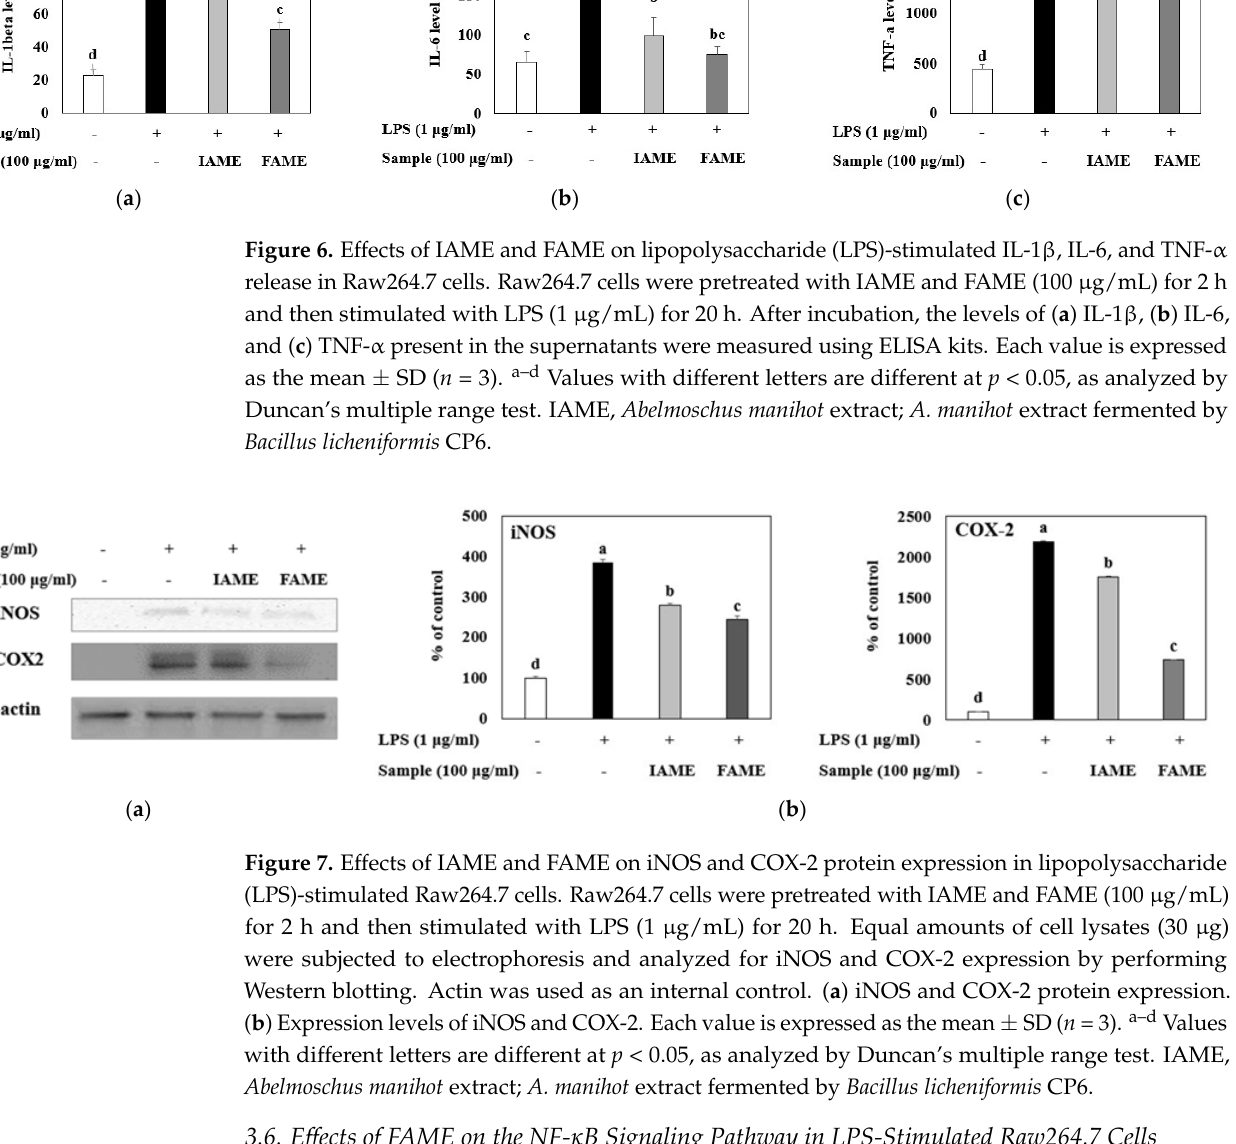
Figure 6. Effects of IAME and FAME on lipopolysaccharide (LPS) ‐ stimulated IL ‐ 1 β , IL ‐ 6, and TNF ‐ α release in Raw264.7 cells. Raw264.7 cells were pretreated with IAME and FAME (100 μ g/mL) for 2 h and then stimulated with LPS (1 μ g/mL) for 20 h. After incubation, the levels of ( a ) IL ‐ 1 β , ( b ) IL ‐ 6, and ( c ) TNF ‐α present in the supernatants were measured using ELISA kits. Each value is ex ‐ pressed as the mean ± SD ( n = 3). a–d Values with different letters are different at p < 0.05, as analyzed by Duncan’s multiple range test. IAME, Abelmoschus manihot extract; A. manihot extract fermented by Bacillus licheniformis CP6.